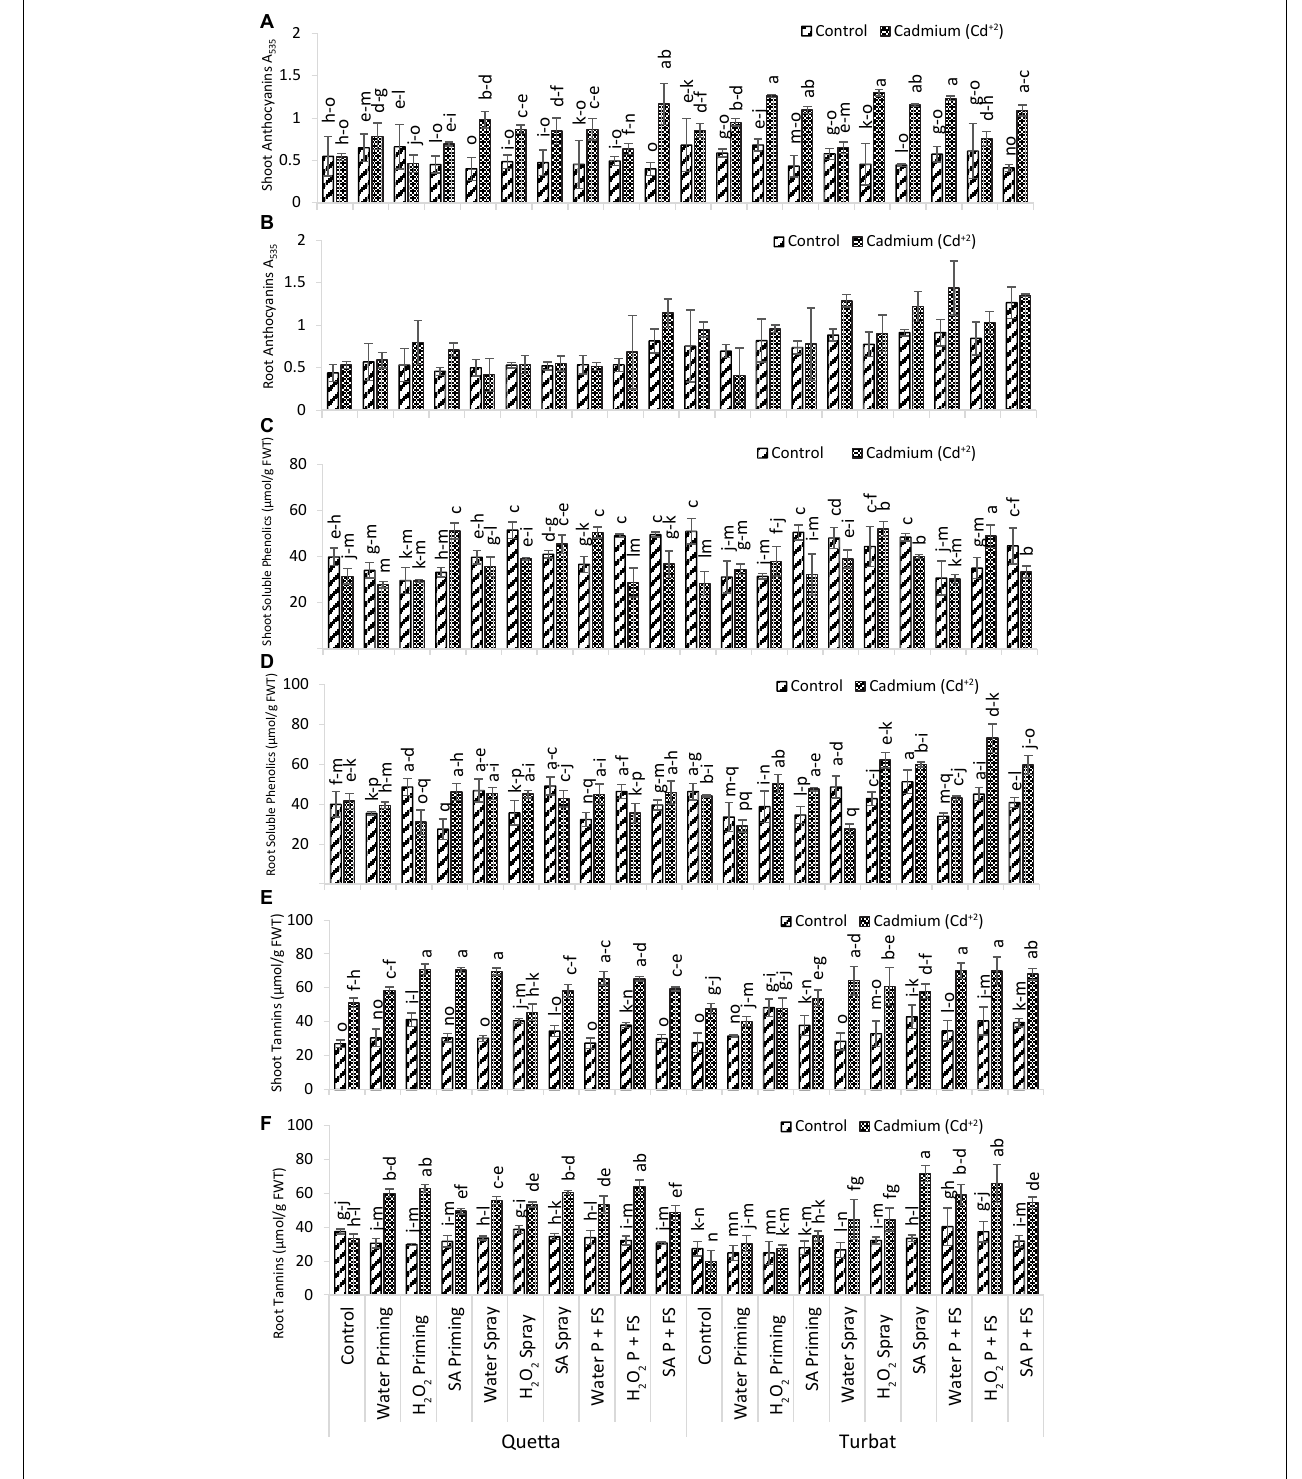
FIGURE 6 | Secondary metabolites; shoot anthocyanin (A) , root anthocyanin (B) , shoot soluble phenolics (C) , root soluble phenolics (D) shoot tannins (E) root tannins (F) of milk thistle as affected by SA and H 2 O 2 treatment grown at Quetta and Turbat under cadmium stress. The same letters on graphs represent a statistically similar effect ( p <